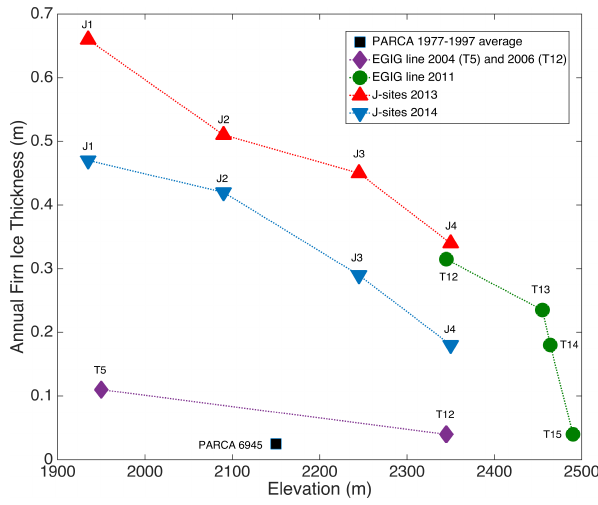
Figure 2. Firn ice content vs. elevation measured in field campaigns between 1998 and 2014. All measurements taken from snow pits except the PARCA 1977–1997 average taken from core